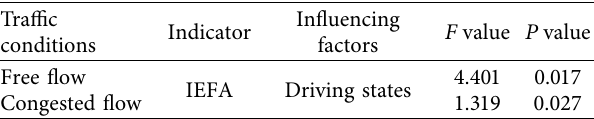
Figure 4: Comparison of drivers’ IEFA for each driving state in diferent trafc conditions. Table 3: One-way ANOVA of the infuence of driving state on IEFA.